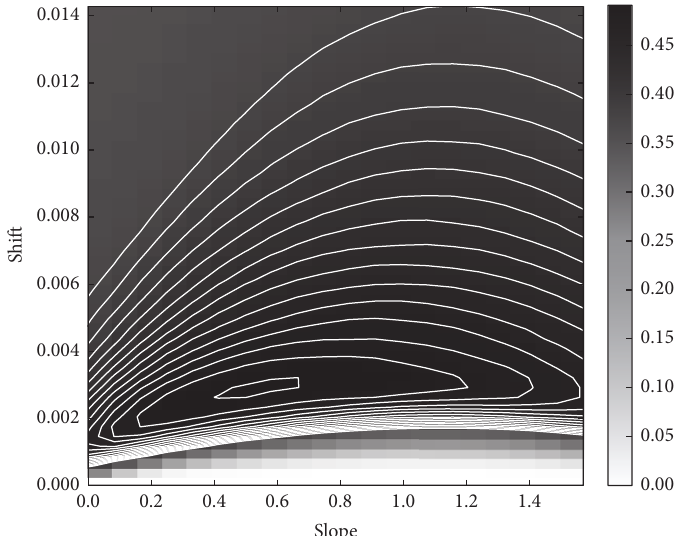
Figure 4: The F 1-score dependence on 𝐶 criterion parameters 𝑎 and 𝑏 , where slope is arctan (𝑎/𝑏) and shift is √𝑎 2 + 𝑏 2